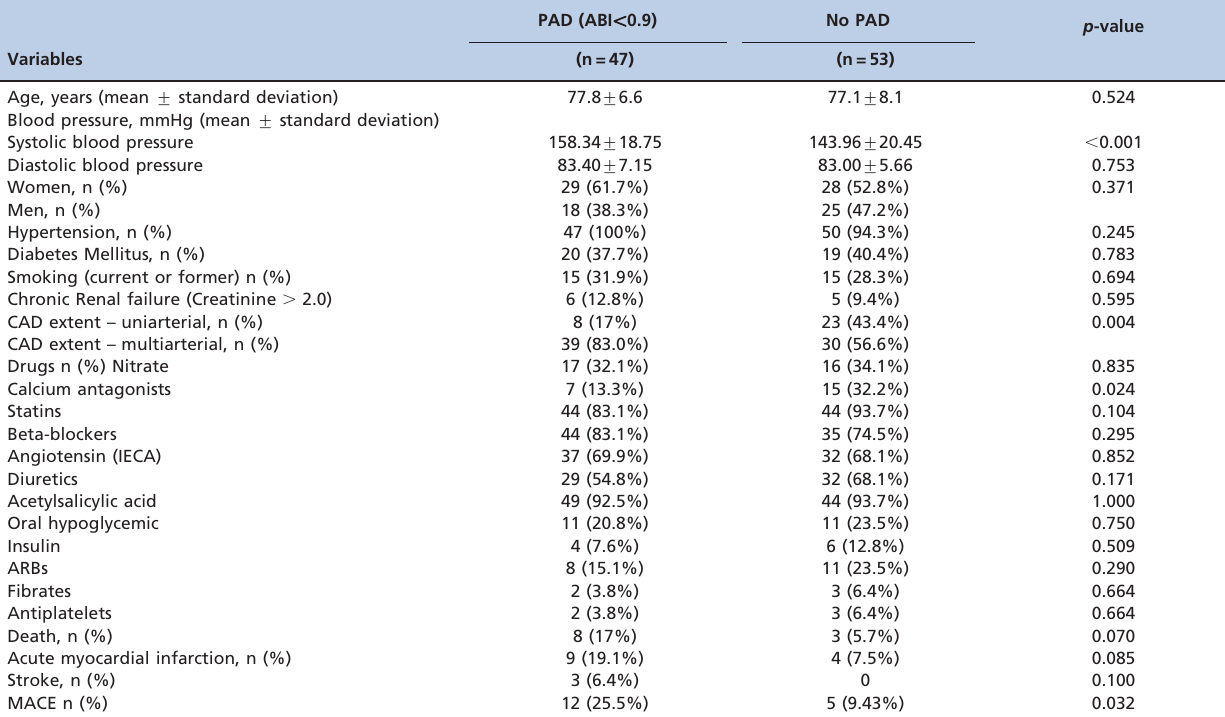
Table 1 - Demographic and angiographic characteristics and the incidence of cardiovascular events in patients with and without PAD.